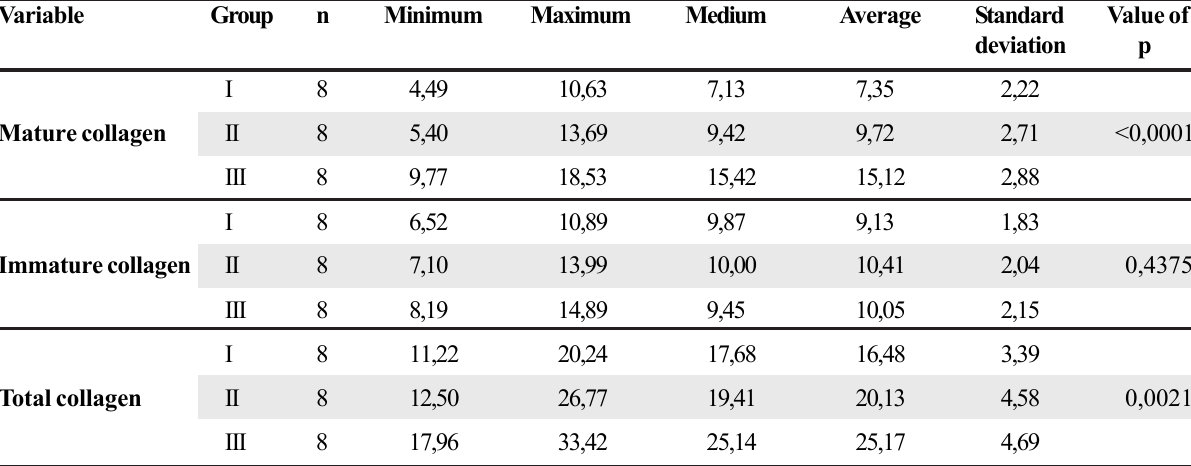
TABLE 2 - Concentration of mature immature and total collagen of the three groups Variable